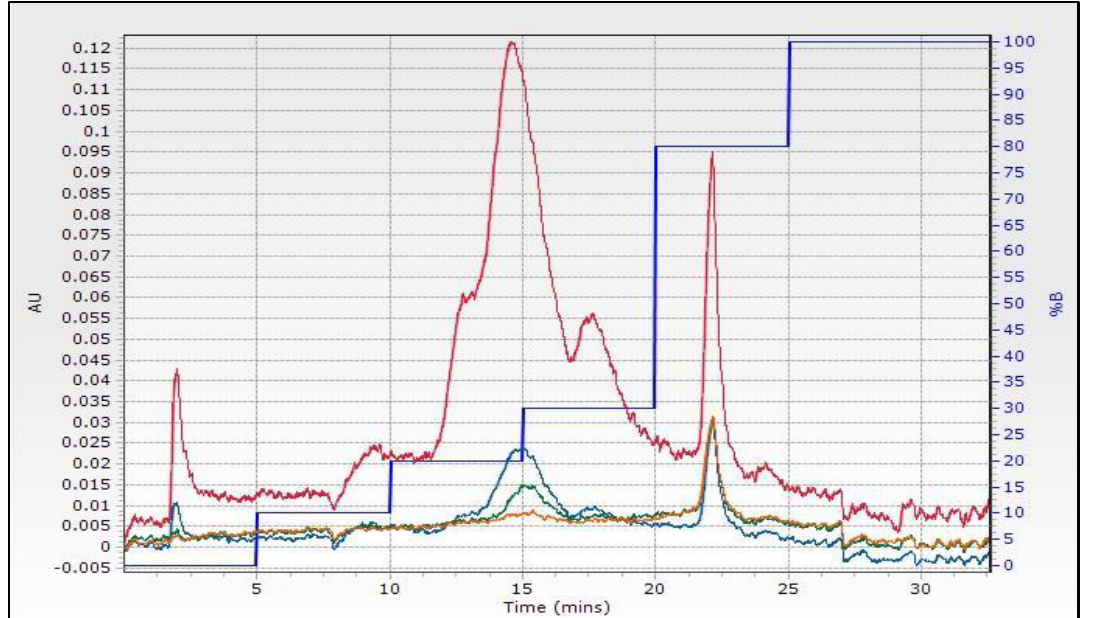
Figure 1. Flash chromatograms obtained following fractionation of the phenolic extract of lyophilized blackberries. Different colors of chromatographic peaks represent different wavelengths, namely 280 nm (Red), 320 nm (Blue), 360 nm (Green), and 399 nm (Yellow). Dark blue line shows the % methanol (%B) gradient.